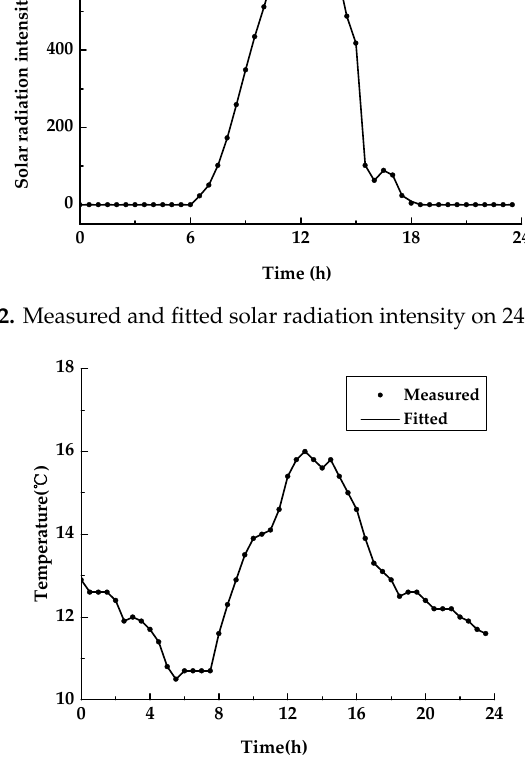
Figure 3. Measured and fitted air temperature on 16 December.